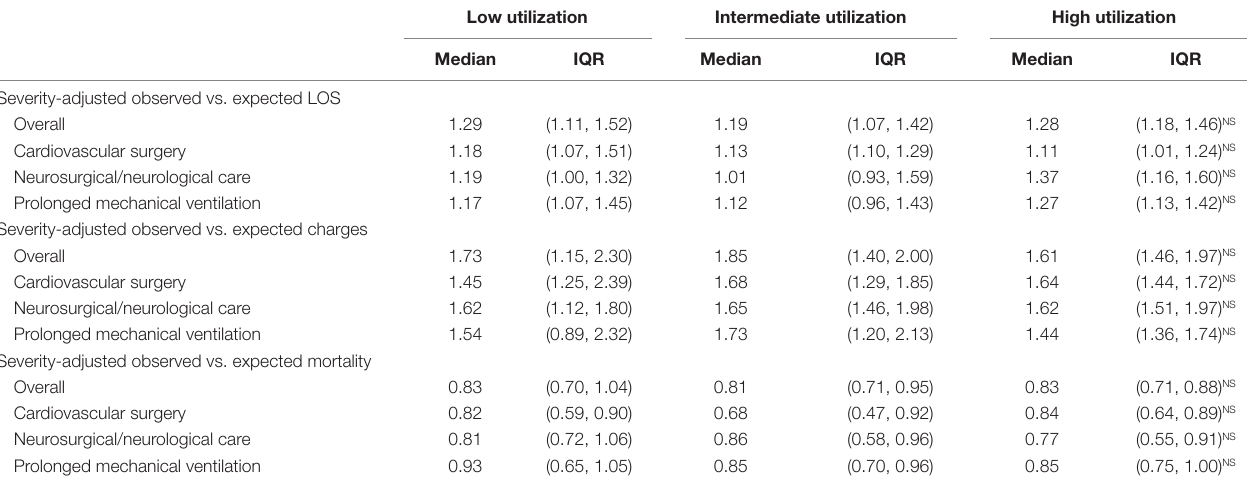
TaBle 3 | indexed hospital-level outcomes among intermediate, high, and low utilization